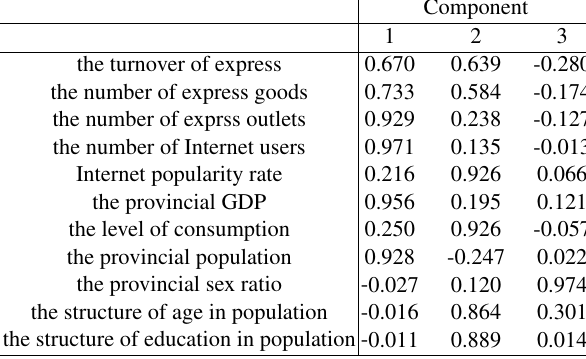
Table 3. Rotation component